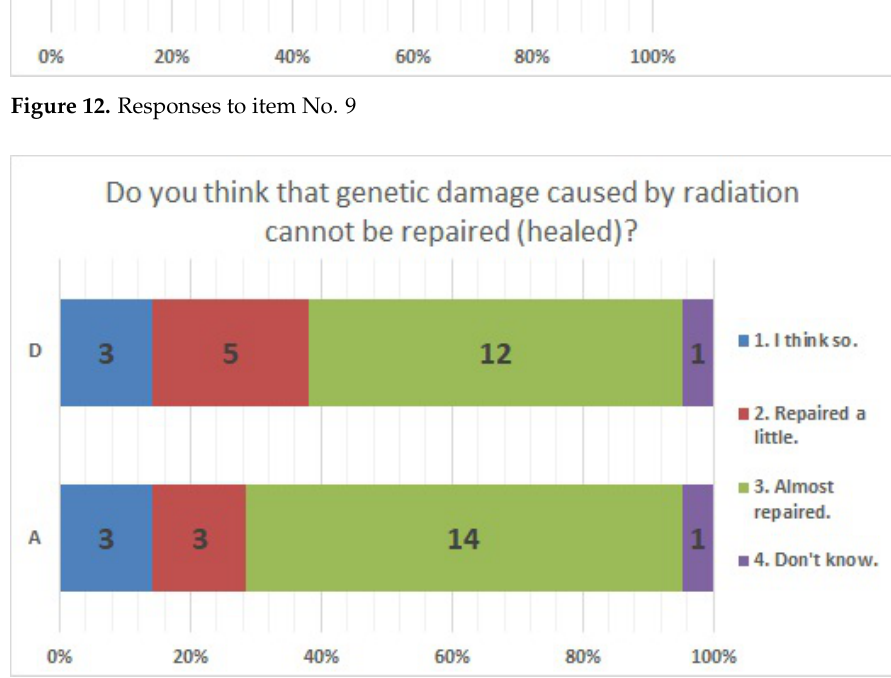
Figure 13. Responses to item No. 11.